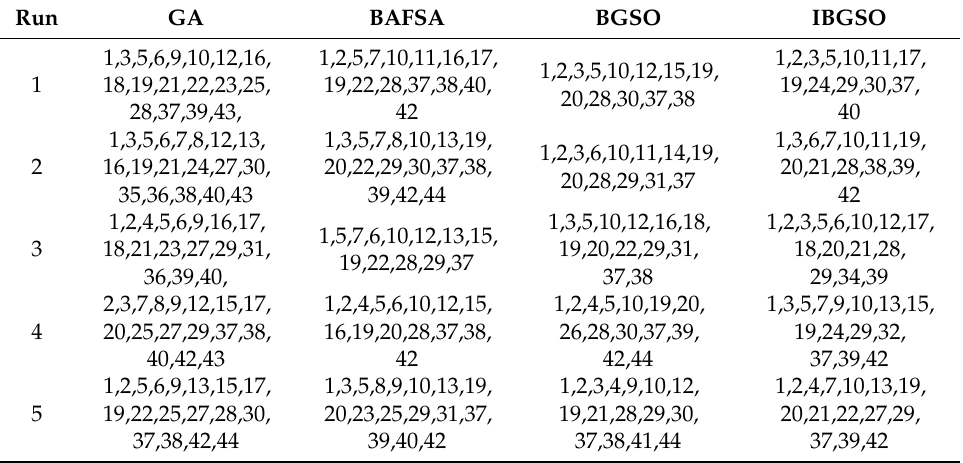
Table 9. Sensor selection results for subject 1 with five runs using the DSA. Run GA BAFSA BGSO IBGSO